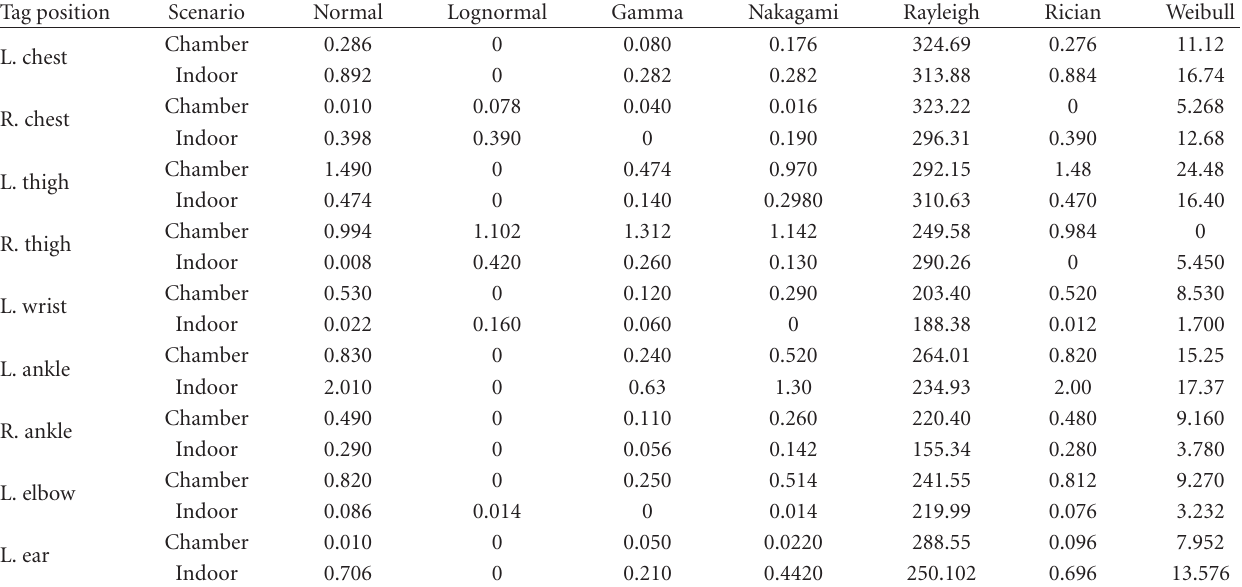
Table 1: Comparison of di ff erent distributions adopting AKAI information criteria for nine on-body links measured in the chamber and